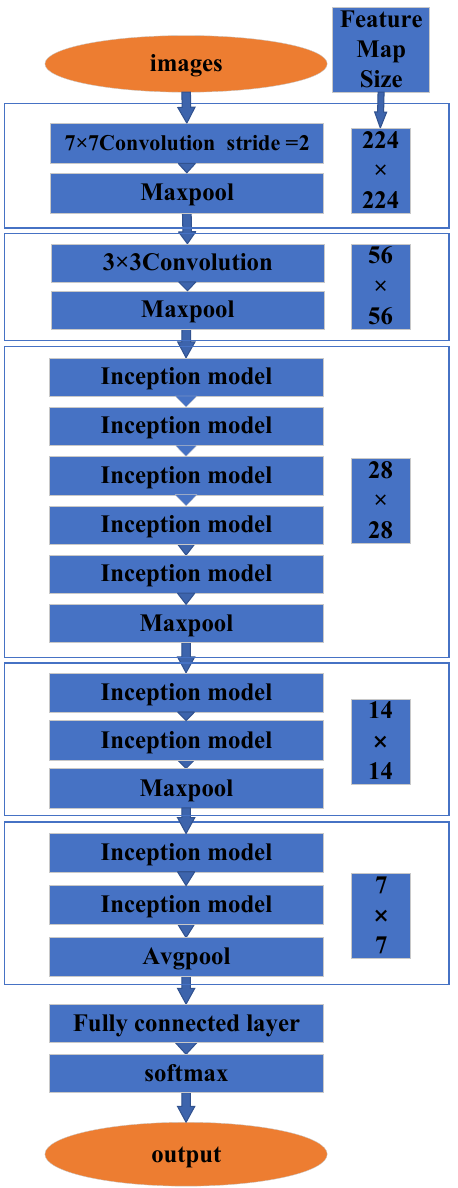
Figure 1. GoogLeNet architecture.